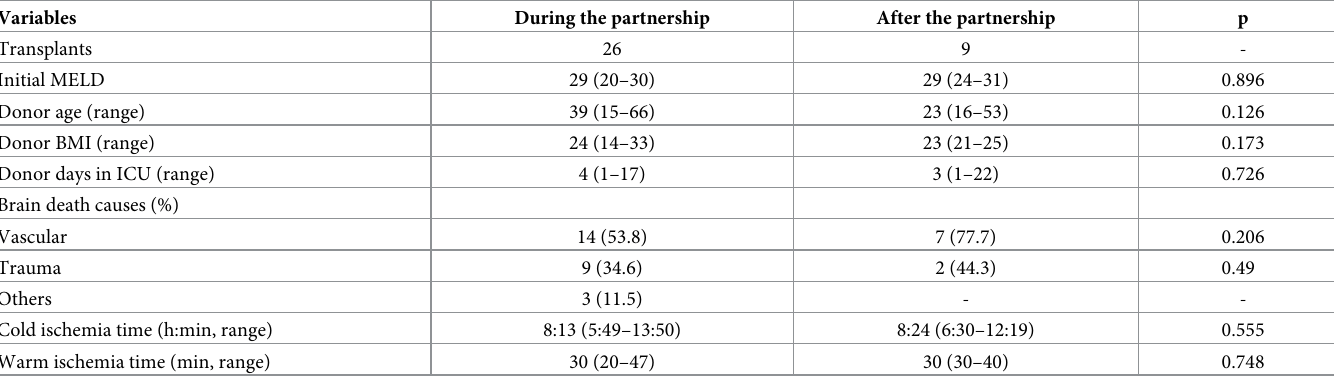
Table 2. Liver transplants carried out in the new center during and after the